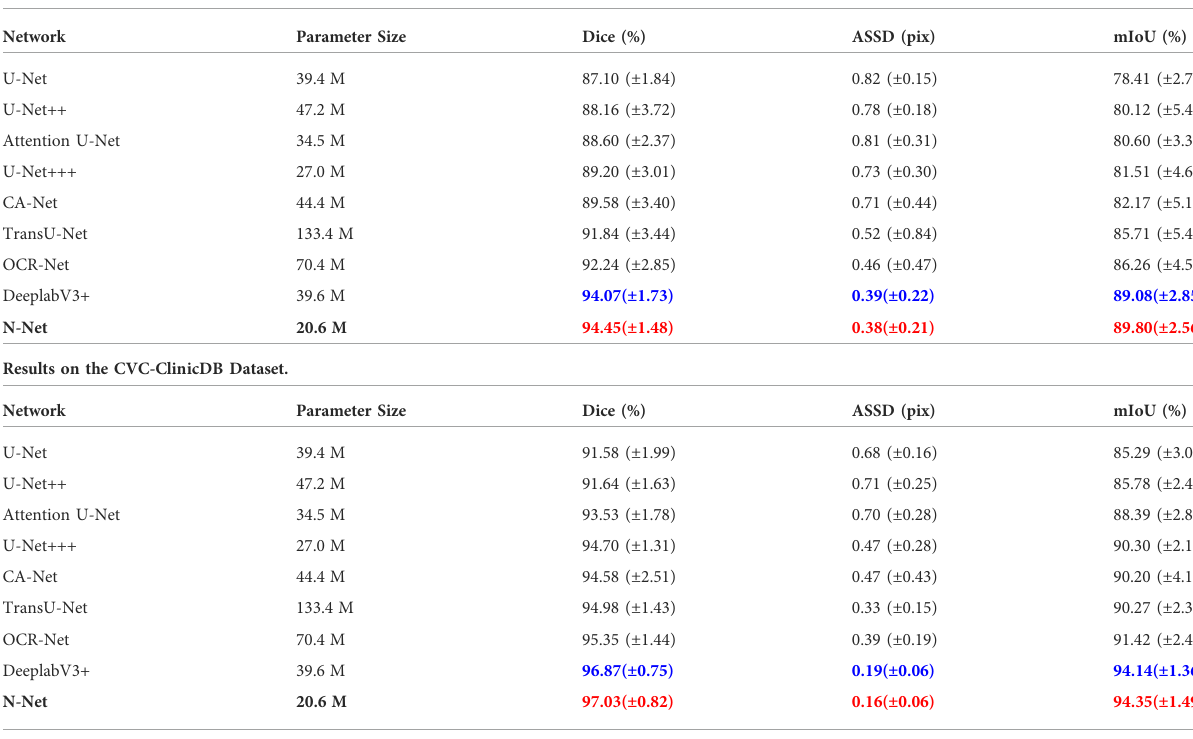
TABLE 5 Performance Comparison of the proposed N-Net to the State-of-the-art Methods on the Two Public Datasets of Colorectal Polyp Segmentations. Results on the Kvasir-SEG